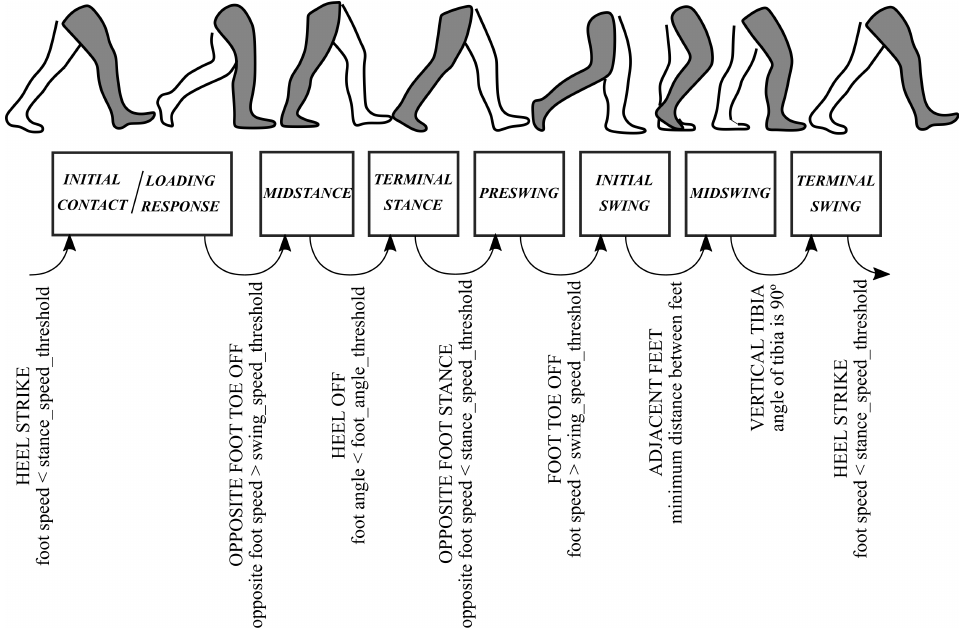
Figure 7. Events used for reference gait segmentation with the information provided by the Percep- tion